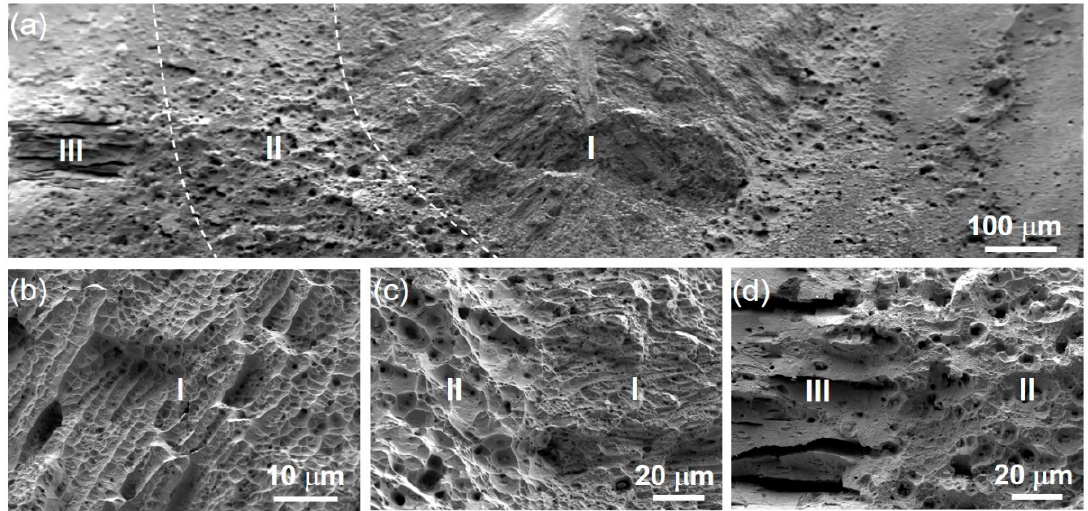
Figure 7. SEM micrographs of the fracture surface for HS sample. ( a ) Low-magnification image showing an overview fracture surface. ( b – d ) High-magnification images showing specific morphologies.